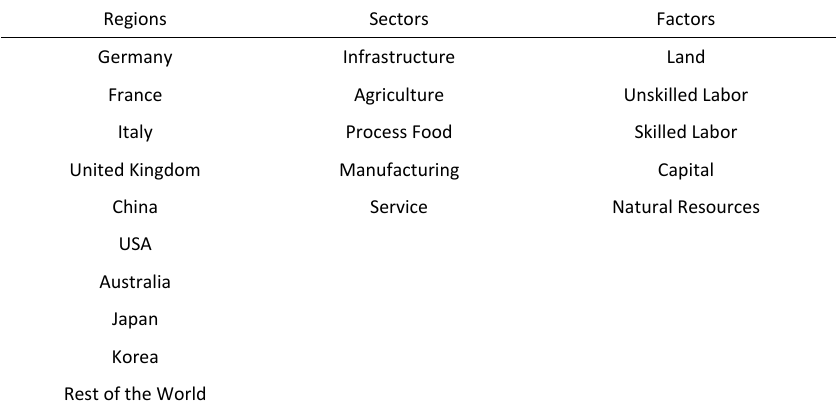
Table 1: Aggregation used in the Model Regions